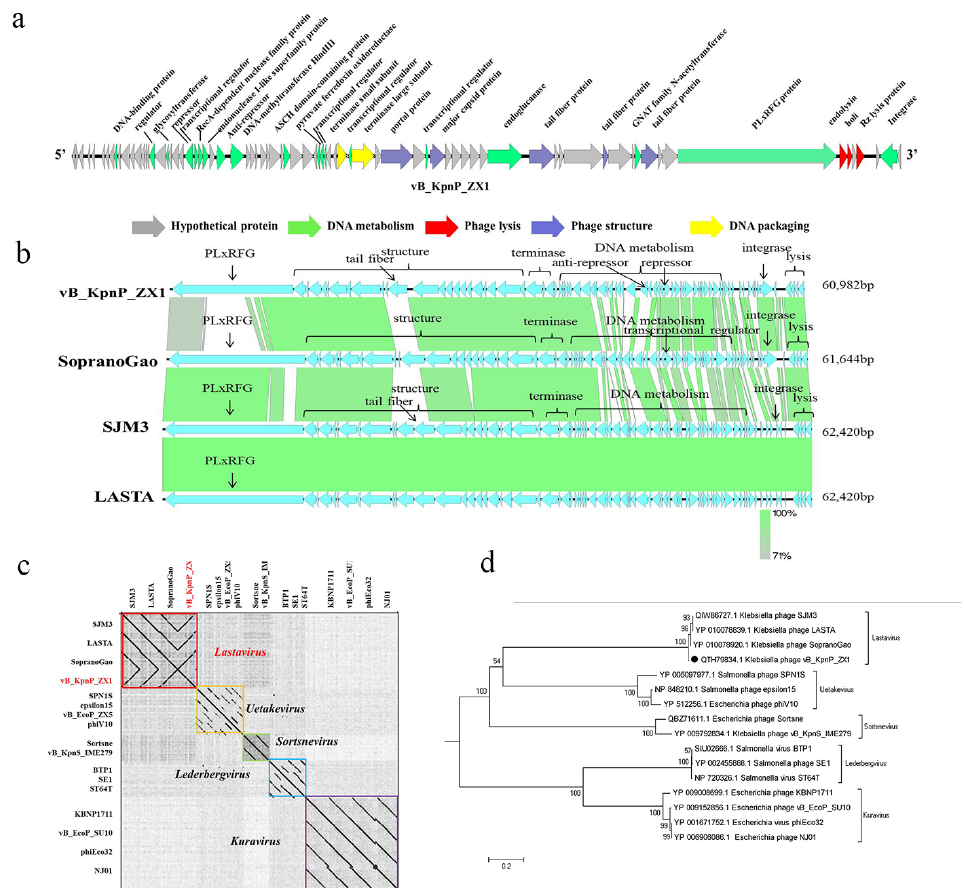
Figure 3. Genomic analysis of phage vB_KpnP_ZX1. ( a ) The genomic characteristics of vB_KpnP_ZX1. ( b ) Comparative genomic analysis of phages vB_KpnP_ZX1, SopranoGao, SJM3, and LASTA. ( c ) Genome dot plot analysis of the phage vB_KpnP_ZX1. Different genome clusters are marked with different colored boxes. ( d ) Phylogenetic tree of the terminase large subunit of the phage vB_KpnP_ZX1.